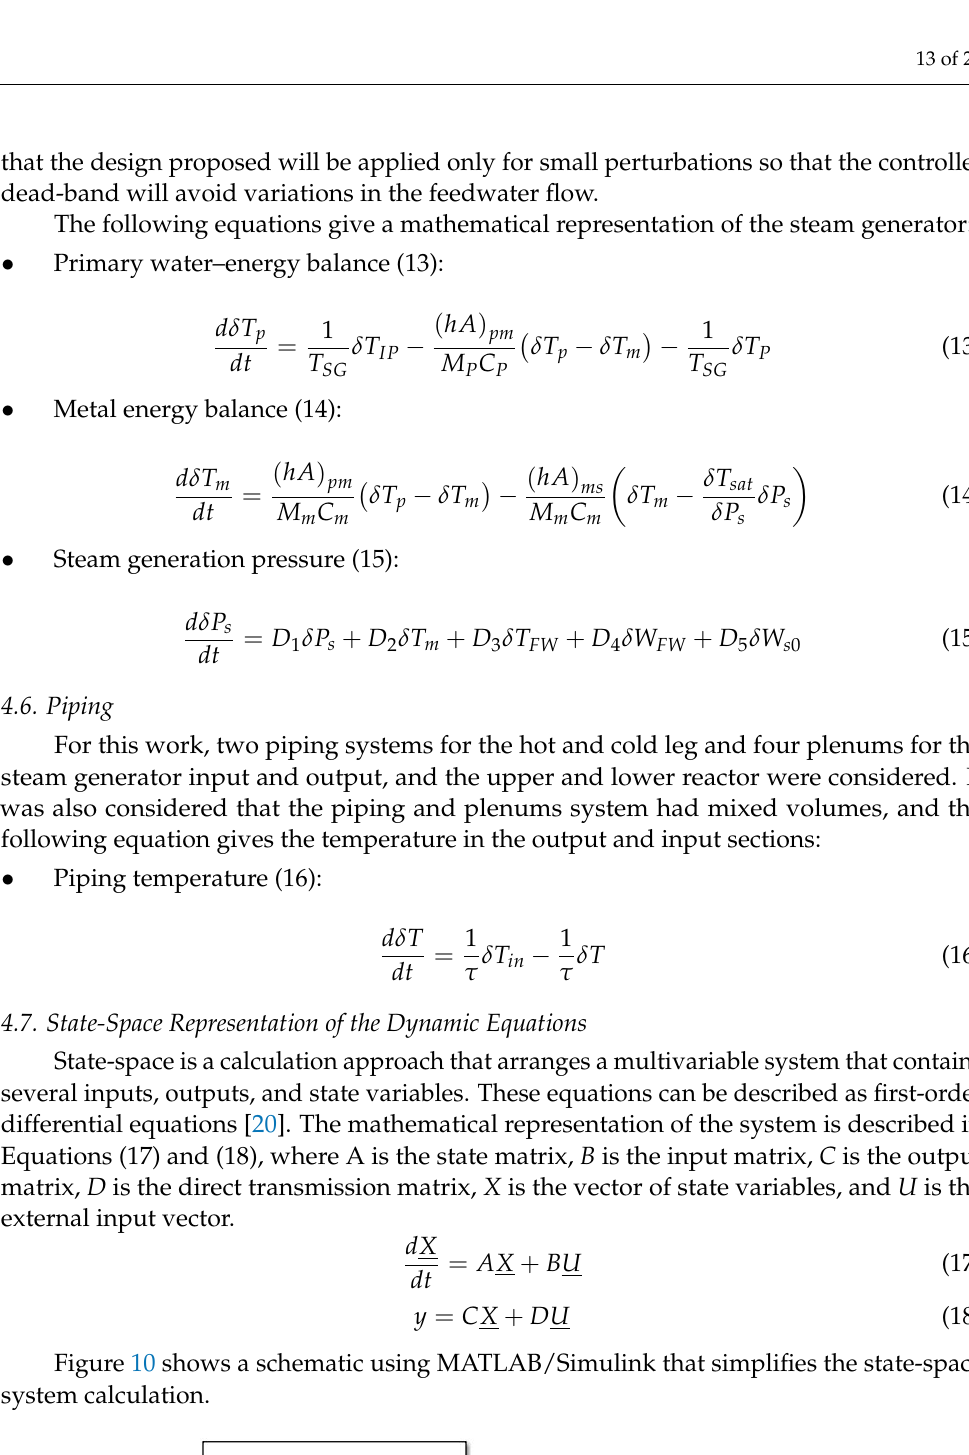
Figure 11. Matrixes X , U , and B for the State = Space system. The matrixes A represent the constants of each equation related to the output varia- bles, and it is presented in Figure 12.